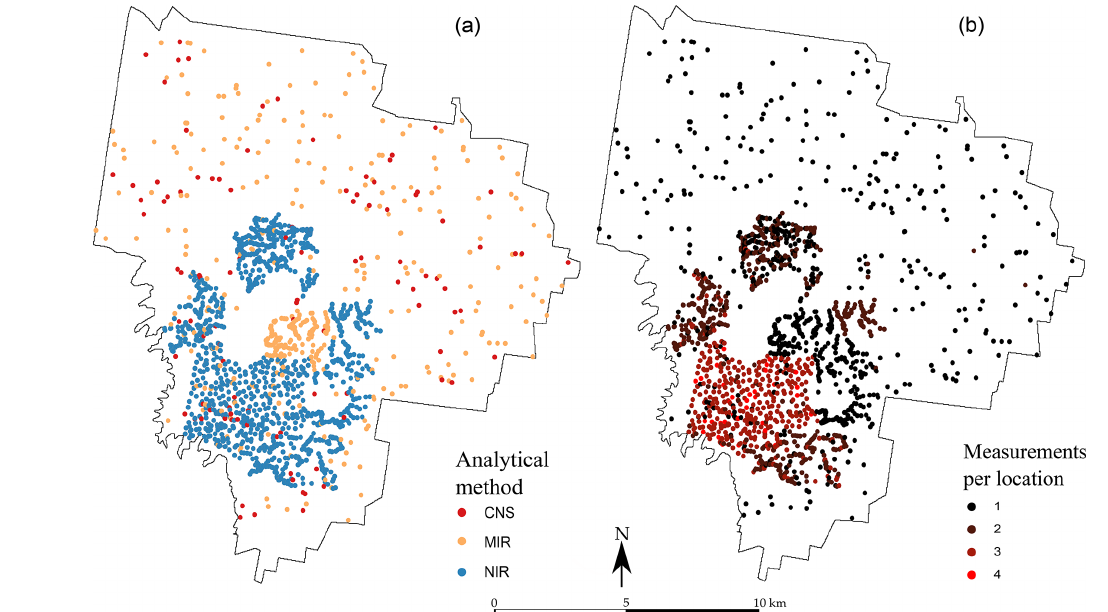
Figure 2. Spatial distribution of the observations for each measurement type (a) for the 0–10cm topsoil and (b) number of measurements recorded per sampling location for the 0–10cm topsoil. The subsoil (40–50cm) map is not shown but closely resembles the topsoil in both number of sampling locations and number of measurements per location.